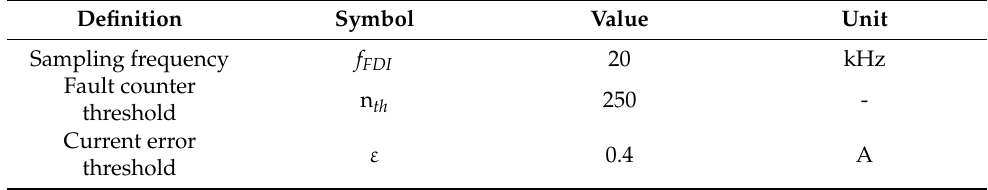
Table A2. FDI algorithm